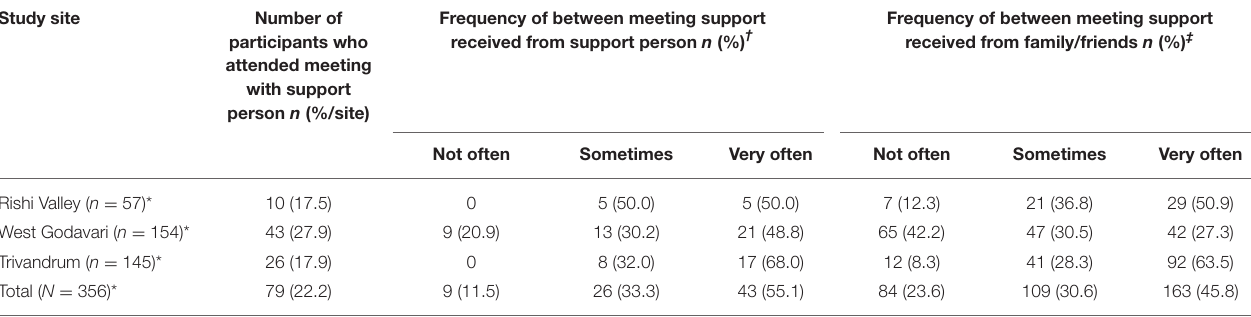
TABLE 4 | Number of participants who attended group meetings with a support person and assessment of the frequency of support, received by participants to use meeting information to improve BP, from support person who attended meetings with the participant and from family/friends who did not attend the group meetings, by study